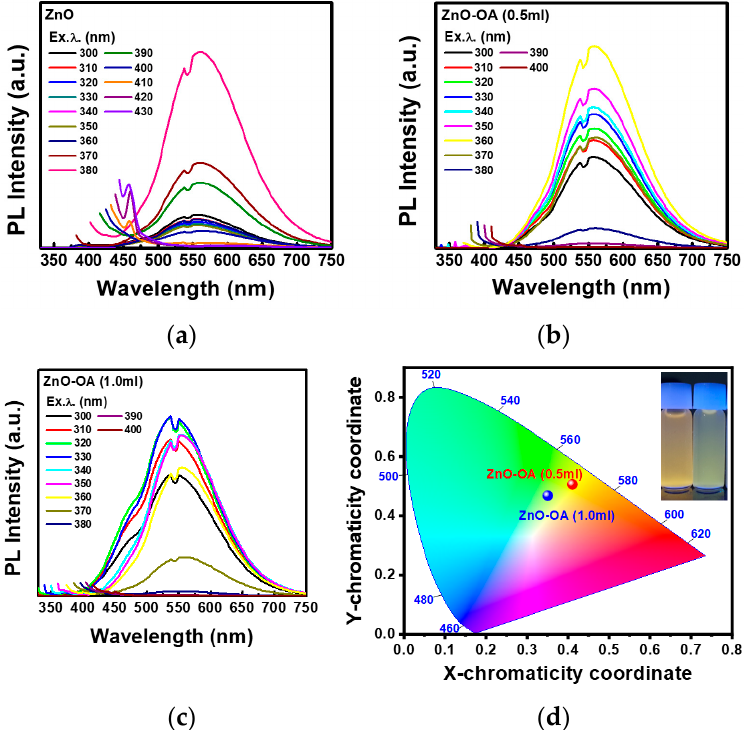
Figure 7. Spectral dependent Photoluminescence spectra of ( a ) ZnO QDS, ( b ) ZnO-OA (0.5 mL), and ( c ) ZnO-OA (1.0 mL) QDs. ( d ) CIE 1931 of ZnO and ZnO-OA (0.5 mL, 1 mL) QDs.